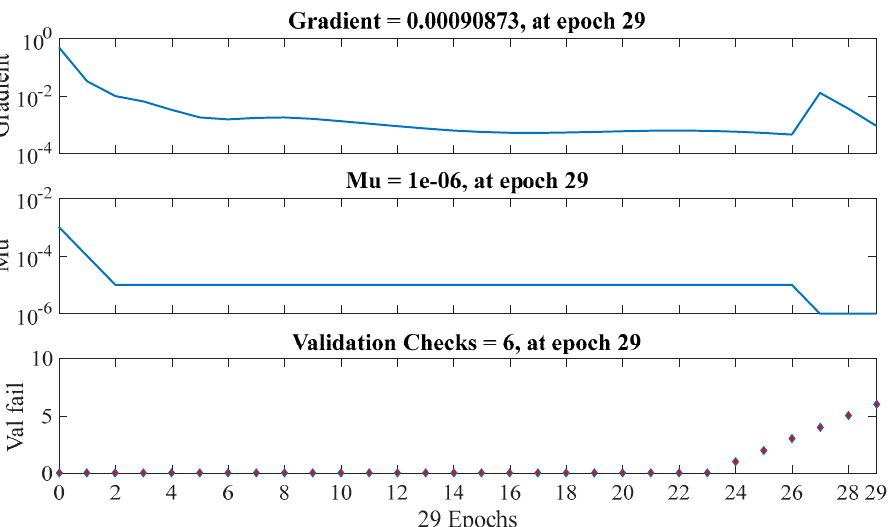
Figure 6. Performance of ANN 6:15:1.